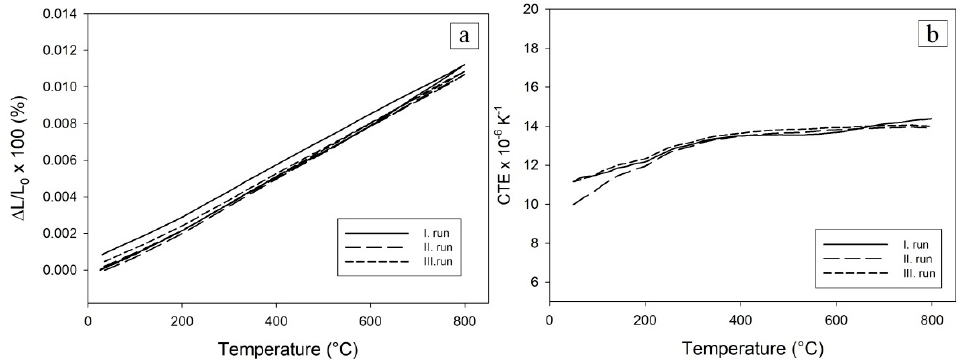
Figure 12. Relative elongation ( a ) and coefficient of the thermal expansion ( b ) were observed for the green compact oxidized to 700 °C and subsequently thermocycled to 800 °C in the Ar atmosphere.